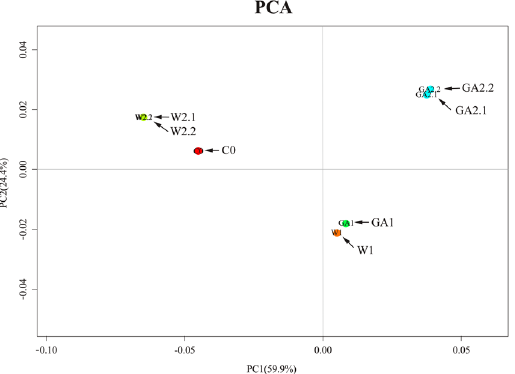
Figure 3. Principle component analysis of different germination stages based on the variation of the expression of differentially expressed